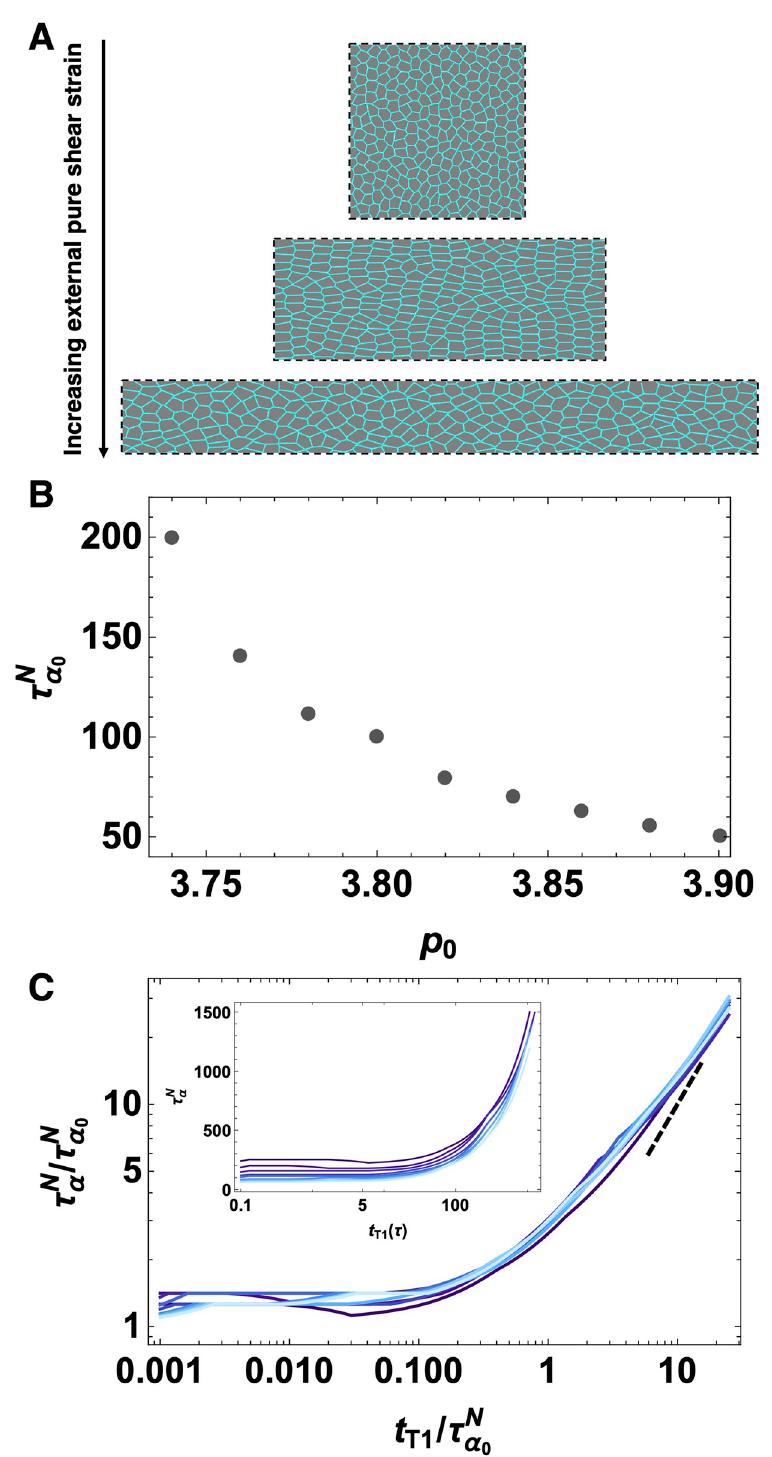
Fig 3. Anisotropic vertex model with external pure shear and T1 delay time. A) We apply an external pure shear on the simulation box which is initially a squared domain of L x = L y = L . We shear the box such that L x = e � L and L y = e − � L . Snapshots are from simulations with p 0 = 3.74, T = 0.02, N = 256 and t T 1 = 1000 τ . B) The collective response time scale t N ( t = 0) for various p 0 values. C) Data collapse for p 0 = 3.74.376, 3.78 ... 3.9 (darker to lighter blue), T = 0.02 T 1 a 0 and N = 256. The characteristic relaxation time, t N as a function of T1 rearrangement delay time normalized by the a collective response timescale t N ð t ¼ 0 Þ . The dotted line is a slope of 1. Inset shows t N the characteristic relaxation a 0 a T 1 time as a function of T1 delay time before normalization for p0 = 3.74, 3.76, 3.78 ... 3.9 (darker to light blue).